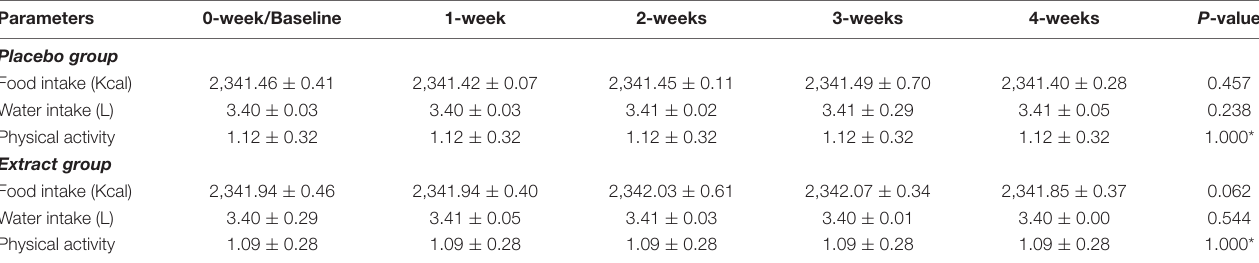
TABLE 7 | Food and water intake, and physical activity (PA) during intervention (0–4 weeks).